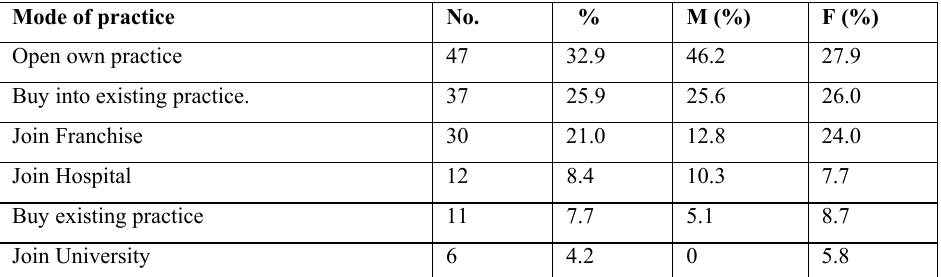
Table 4: Modes of practice considered to the best way of entering practices, number/ percentage of respondents and within gender percentages